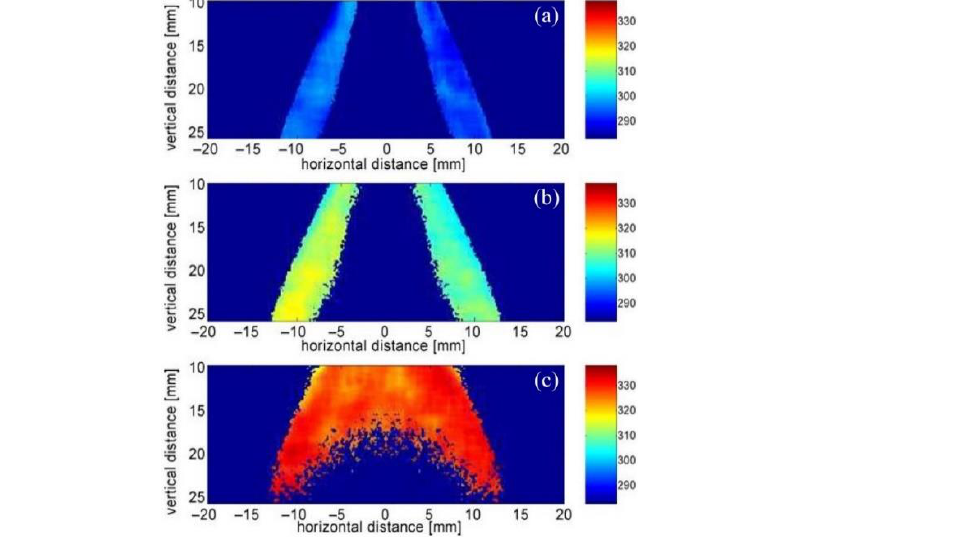
Figure 21. Temperature fields of spray with different initial liquid-phase temperatures: ( a ) T = 296 K, ( b ) T = 343 K, ( c ) T = 393 K [92]. Reprinted with permission from [92]. Springer Nature, 2006.